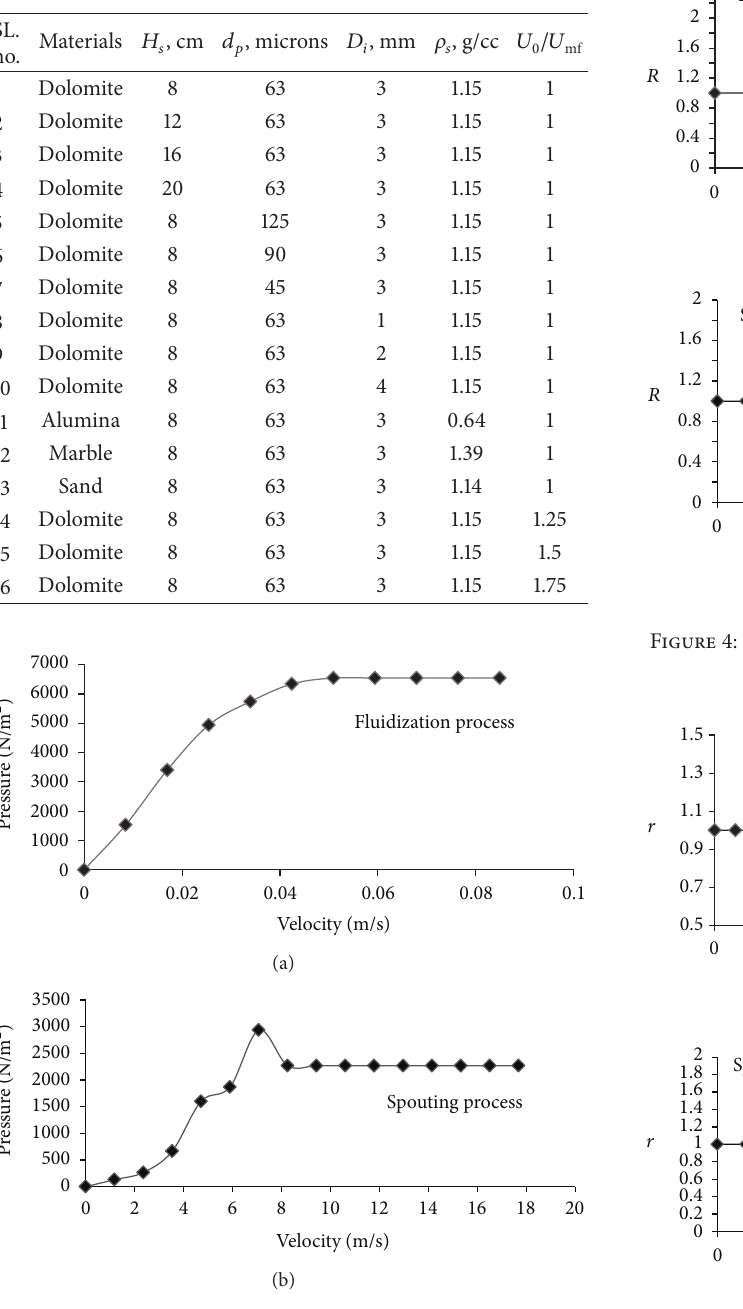
Figure 3: Comparison of bed pressure drop profiles for fine particles.